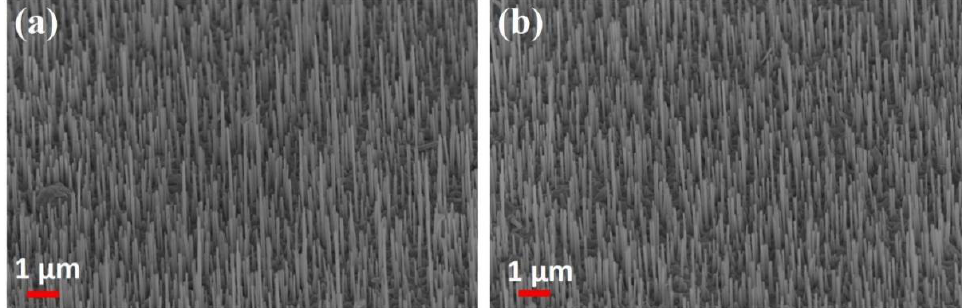
Figure 2. SEM images of ( a ) as-grown and ( b ) annealed n-GaAs nanowires with the As flux during droplet consumption the same as growth. droplet consumption the same as